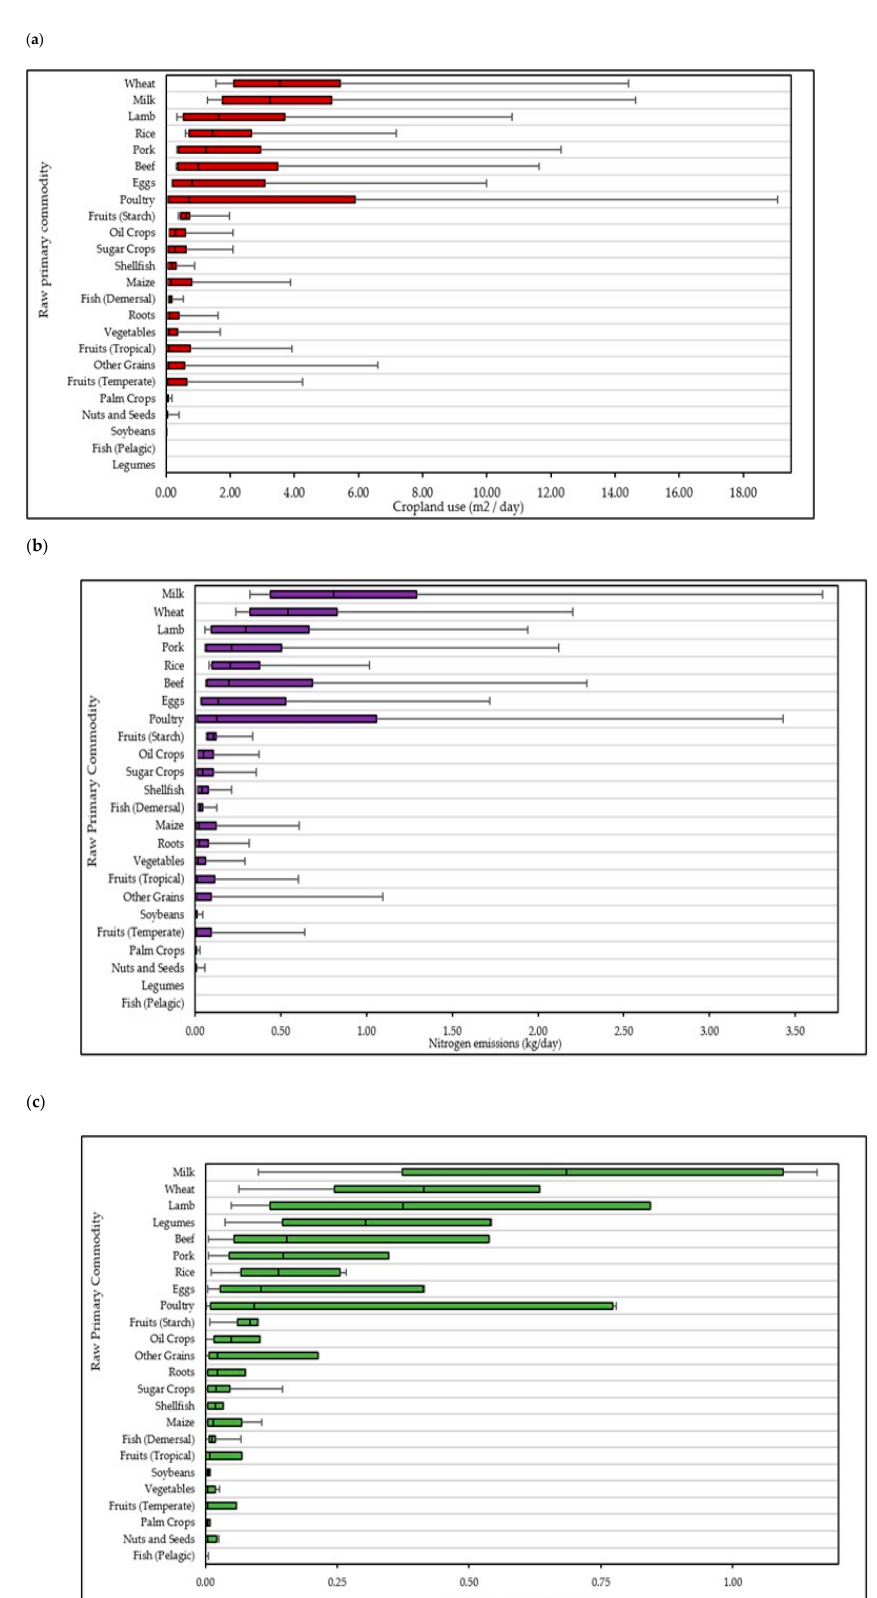
Figure 3. The main contributors to greenhouse gas emissions and blue water use across the popula- tion groups by actual intake amounts. Values shown as median, interquartile range (IQR) with 95% confidence intervals shown. Highest median contribution to each factor shown.